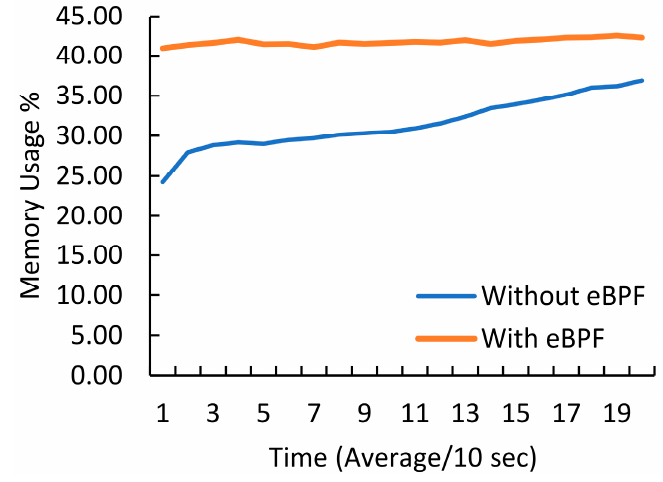
Figure 7. Worker Node Memory Overhead Analysis.